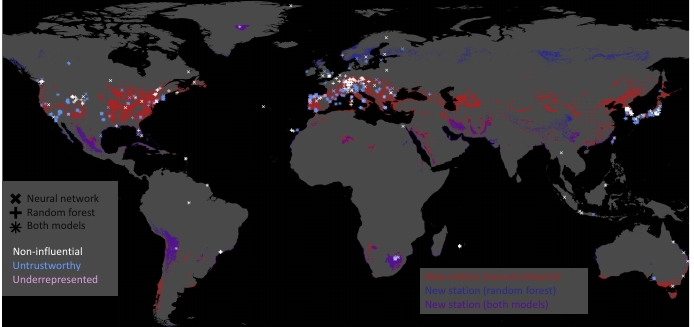
Figure 11. Map showing non-influential training stations in white, untrustworthy predictions on the test set in blue, and underrepresented test stations in plum. The marker indicates the model on which these stations were derived. The neural network’s marker is × , the random forest’s marker is + , and where those two symbols overlap, we get something like an asterisk ∗ . Moreover, we indicate regions where the models recommend building new stations in red, blue, and violet. The neural network recommends building new stations in red-colored areas; the random forest recommends building new stations in the blue-colored areas. Violet represents the intersection of regions recommended by both